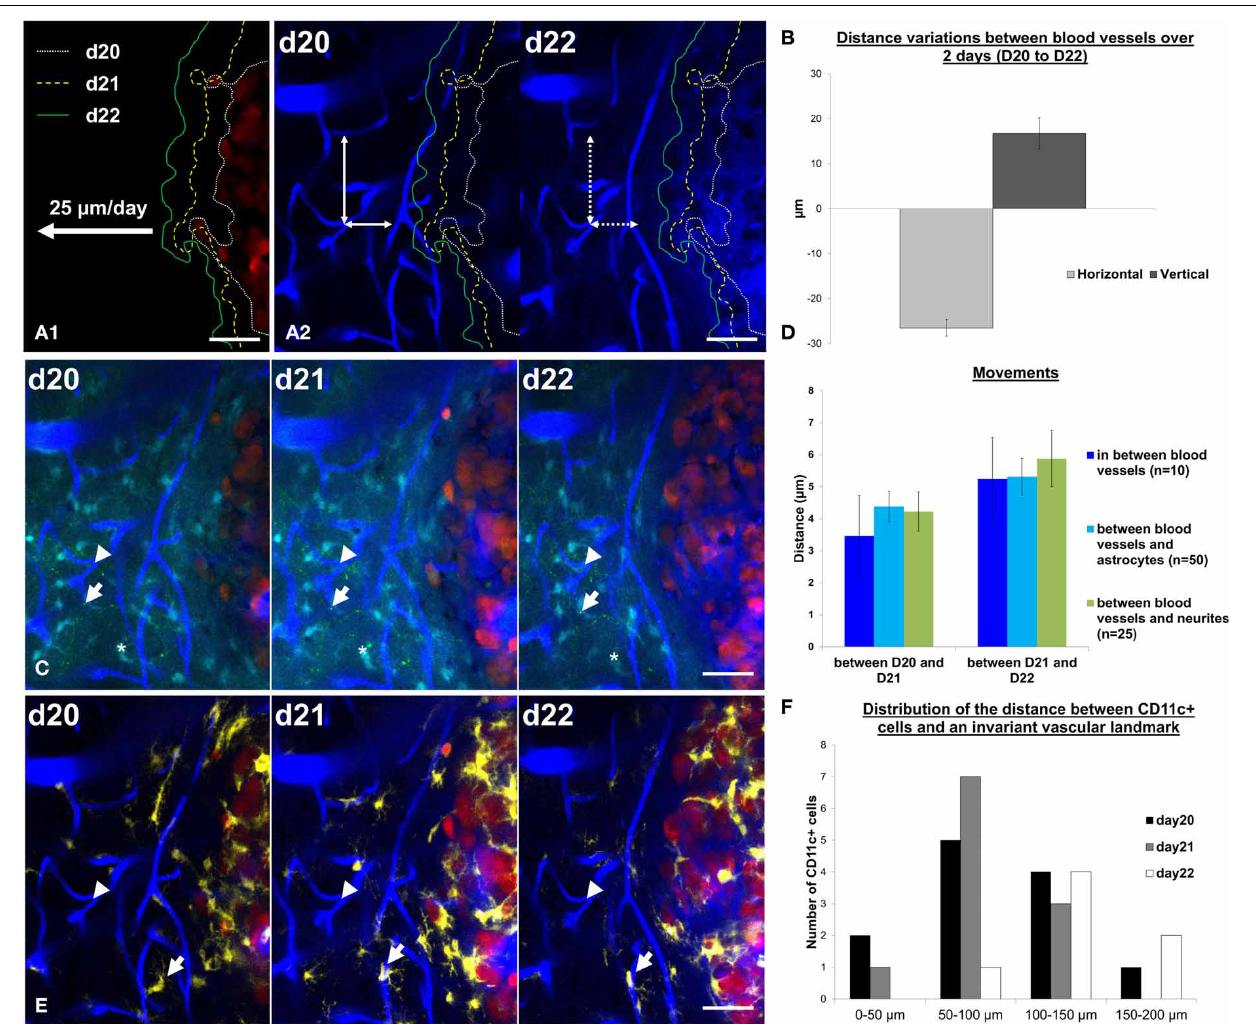
FIGURE 5 | Cell dynamics and deformations due to tumor growth can be tracked over time. (A1) Tumor margin are highlighted at day 20 (d20, white small dotted line), day 21 (d21, yellow dotted line) and day 22 (d22, green line). Tumor expansion rates were measured at 25 ± 2 μ m/day. (A2) Tumor margins at d20, d21, and d22 were overlaid on vasculature images at day 20 and day 22. Notice the decrease of the distances between blood vessels in the horizontal direction (in the direction of tumor growth, horizontal double-arrow) and an increase in the vertical direction (perpendicular to the direction of tumor growth, vertical double-arrow). Movements between d20 and d22 are highlighted by the mismatch between arrowheads and vessel walls (dotted line on d22). (B) Quantification of the distance variation ( μ m) between blood vessels in the horizontal direction (in the direction of tumor growth, light gray) and in the vertical direction (perpendicular to the direction of tumor growth, dark gray). (C) z-projection of 6 slices over 15 μ m in the same field of view at